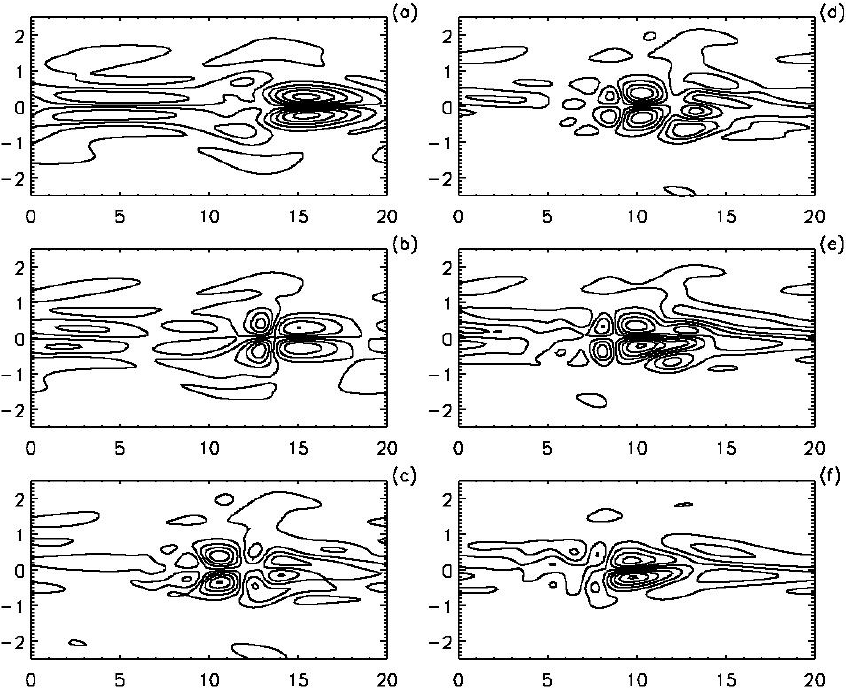
Fig. 15. Contour plots of potential temperature for the evolution of our initial perturbation in the presence of the dual ducting structure presented in Fig. 15, panel (a). Times are 32, 45, 69, 77, 83,